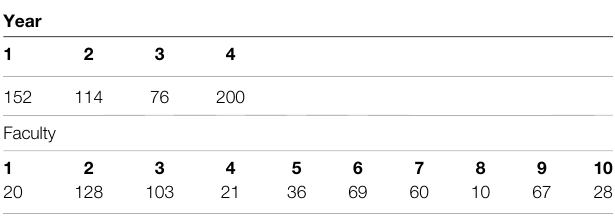
TABLE 1 | Sample breakdown by year and